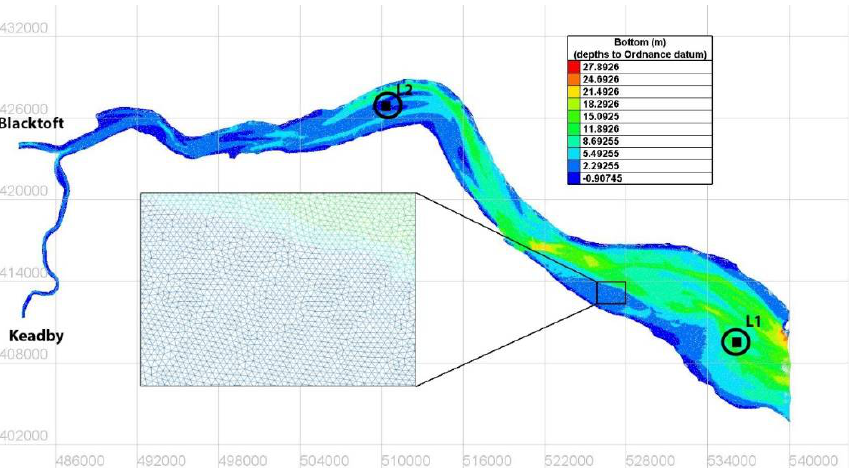
Figure 2. Bathymetry and computational domain for the Humber Estuary simulations. Release points for oil spill scenarios are indicated as L1 and L2, respectively, at 536,528; 409,627 and 510,498; 426,777 (coordinates are in OSGB 1936). Inset shows the detail of the computational